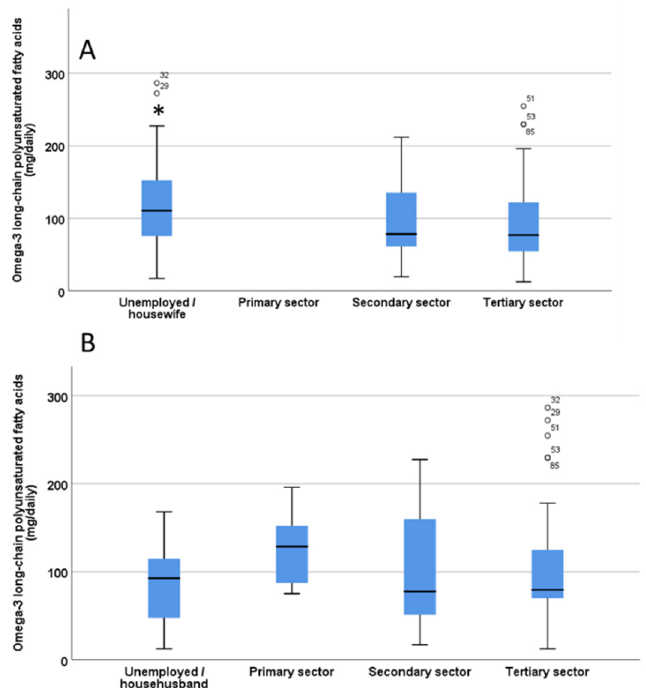
Figure 3. Estimation of omega-3 long chain polyunsaturated fatty acids (LC-PUFA) intake from fish / seafood in children / adolescents based on the mother’s work ( A ) and father’s work ( B ). The significant di ff erence in Panel A is indicated by the asterisk * p < 0.05. ◦ indicate outliers defined as a data points located outside the whiskers of the box plot. No significant di ff erences ( p = 0.90) were found in the O3 intake of children / adolescents between children living with one parent and those living with both parents. There were significant di ff